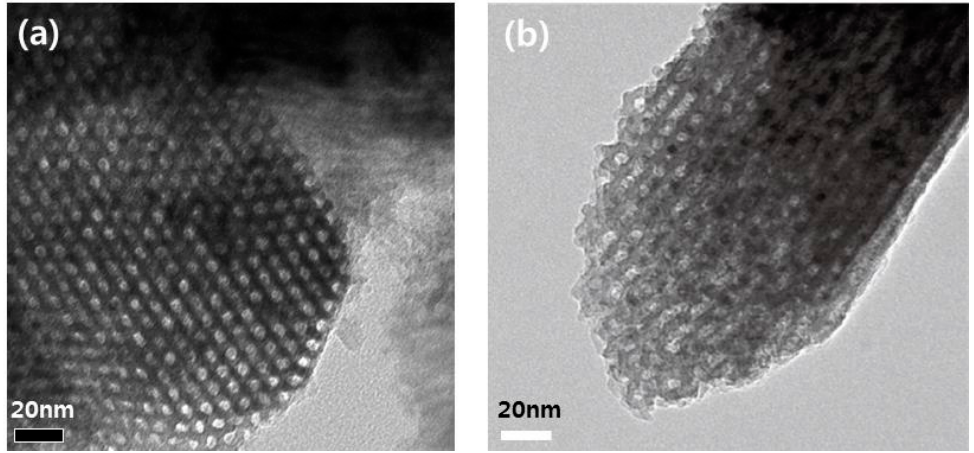
Figure 2. TEM images for ( a ) SBA ‐ 15; ( b ) Ni 2 P/SBA ‐ 15 catalyst.